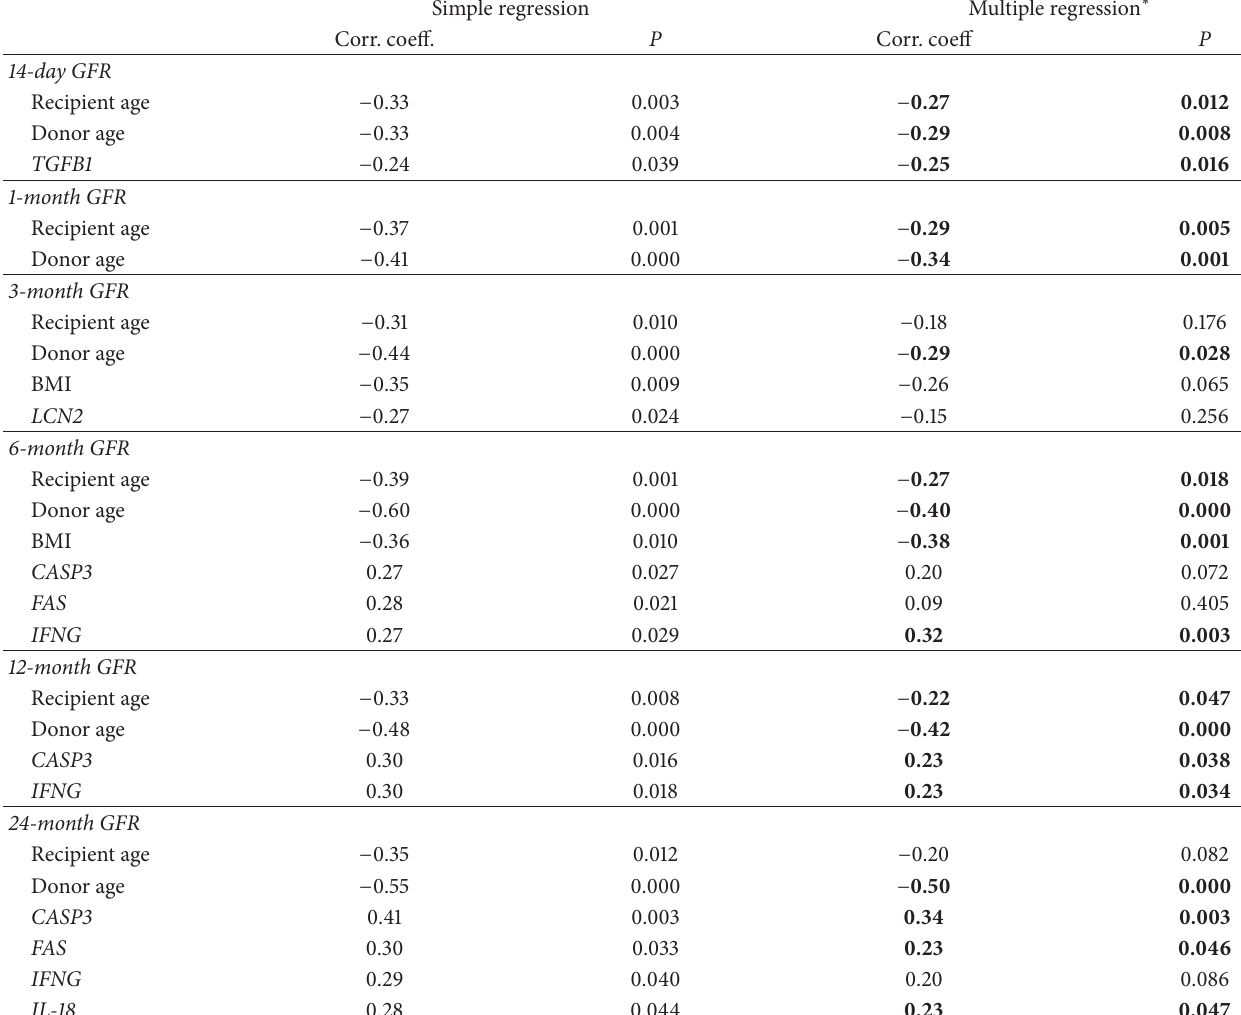
Table 5: Correlation of gene expression and pretransplant clinical parameters with GFR—simple and multiple linear regression analysis. Simple regression